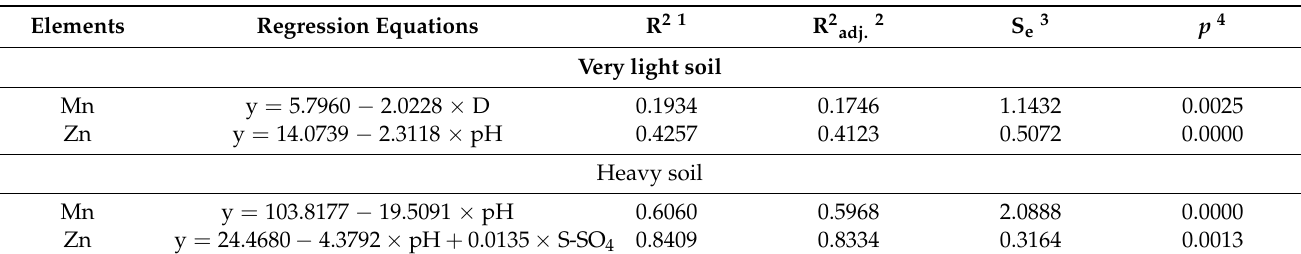
Table 6. Estimated equation parameters and statistics for stepwise (backward elimination) multiple regression of tested